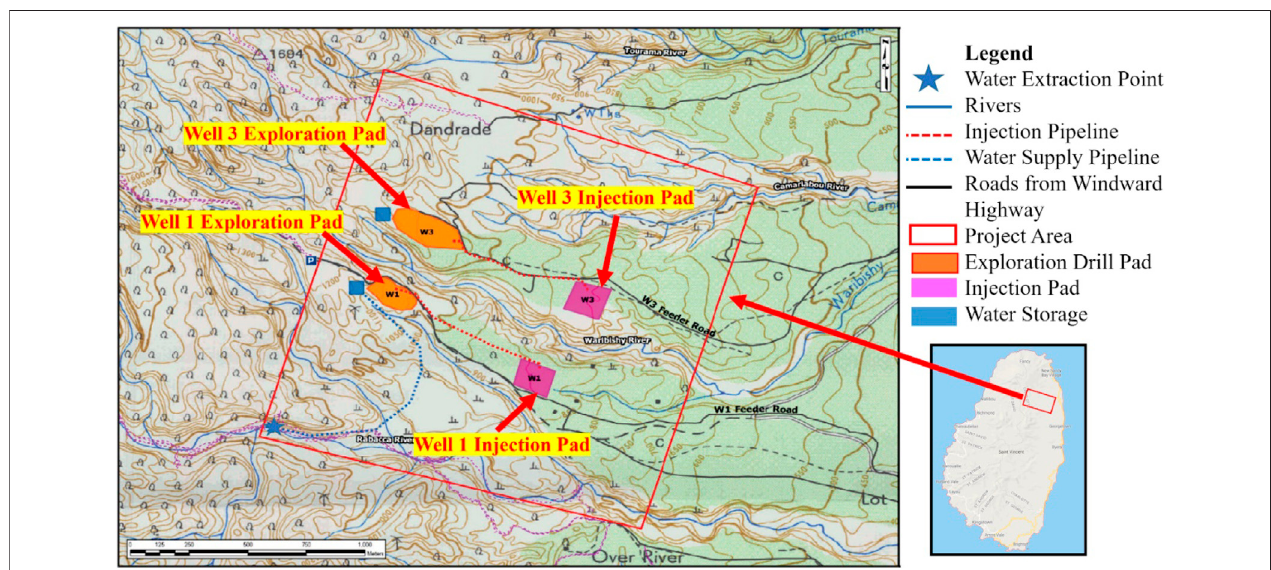
FIGURE5 | Reconstructed map of the geothermal resource and exploration site ofphase one ofSt. Vincent geothermal plant. This Figure has been reconstructed with permission granted from Reykjavik Geothermal Limited (Source: ERM, 2016).